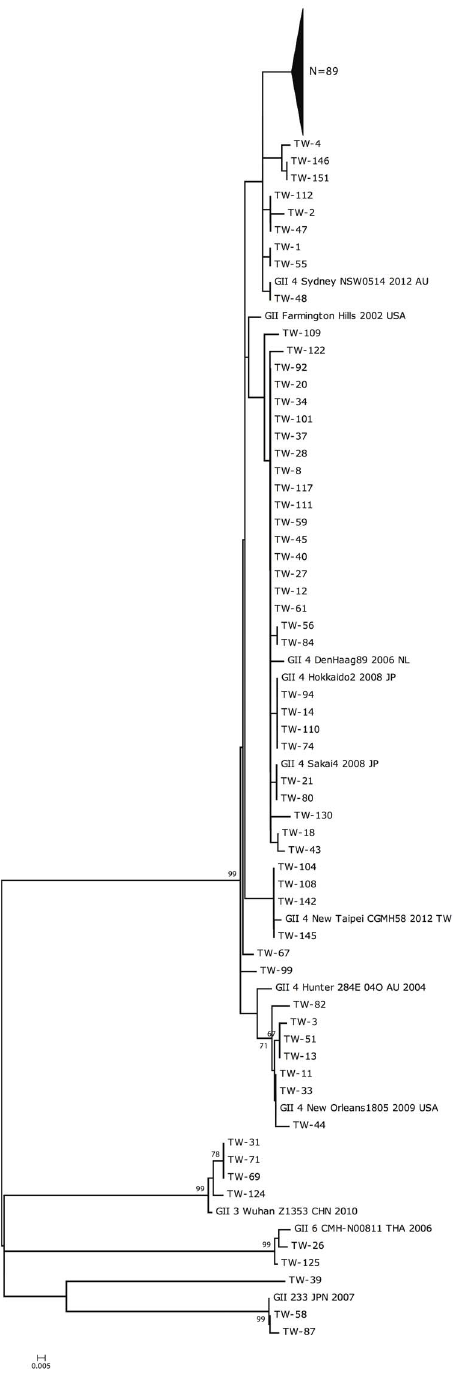
Figure 1. Phylogenetic analysis of viral protein 1 sequences from 154 strains of norovirus. Footnote of Figure 1: A total of 11 reference norovirus strains were included in the analysis. Except for strains of GII3 Wuhan Z1353 CHN2010, GII 6 CMH-N00811 THA 2006 and GII 233 JPN 2007, the other 8 reference strains were close related to the GII 4 Sydney